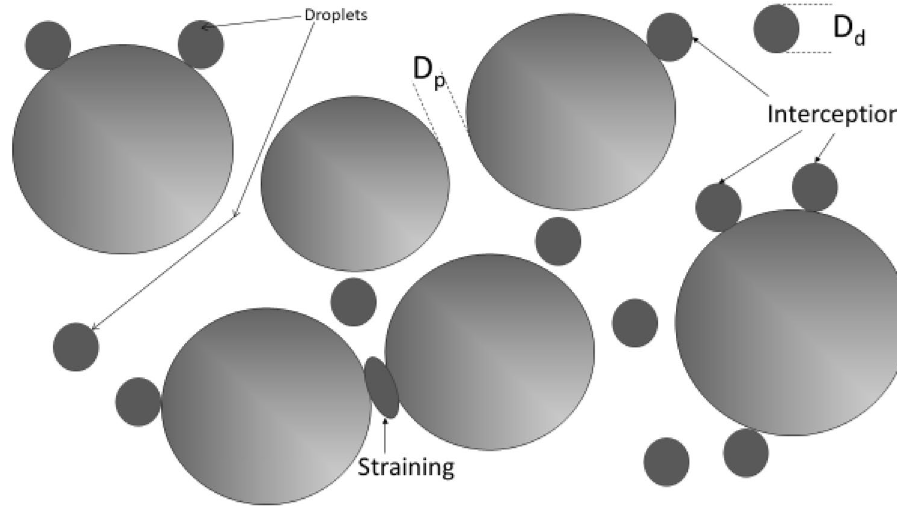
Fig. 2 Different capture modes of emulsion in a porous media of